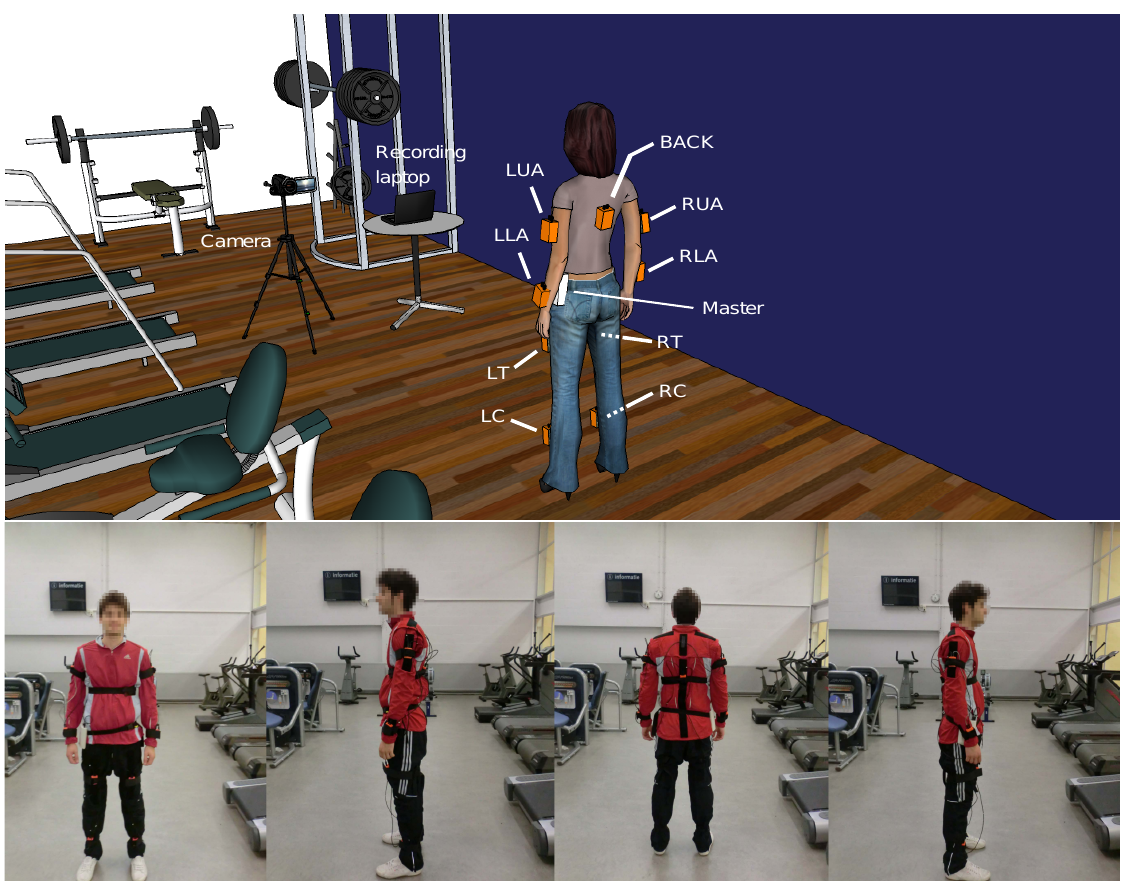
Figure 3. Experimental setup (cardio-fitness room). Eight Xsens units are placed on each body limb and an additional one on the back. A laptop is used to store the recorded data and for labeling tasks. A camera records each session for offline post-processing. Sensor legend: left calf (LC), left thigh (LT), right calf (RC), right thigh (RT), back (BACK), left lower arm (LLA), left upper arm (LUA), right lower arm (RLA) and right upper arm